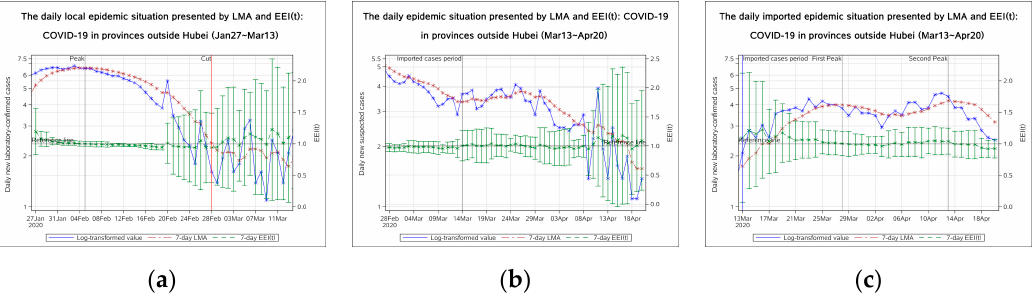
Figure 3. The daily epidemic situation presented by LMA and EEI(t), COVID-19 in provinces outside Hubei. ( a ) From 27 January to 13 March 2020; ( b ) From 28 February to 20 April 2020; ( c ) from 13 March to 20 April 2020. The blue line indicates the change of the log-transformed value over date. The brown line indicates the change of 7-day LMA over date. The green line indicates the change of the EEI(t) over date. LMA, moving average of log-transformed daily new cases and EEI(t), epidemic evaluation index (t).